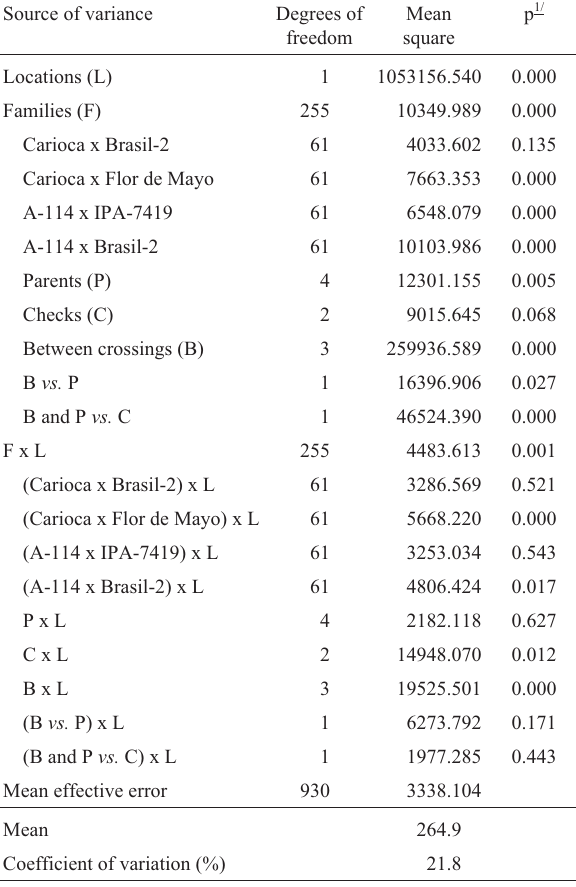
Table III - Joint analysis of variance of seed yield, in g/plot, of F lies from the crossings among common bean cultivars, evaluated in Lavras-MG and Patos de Minas-MG, Brazil.